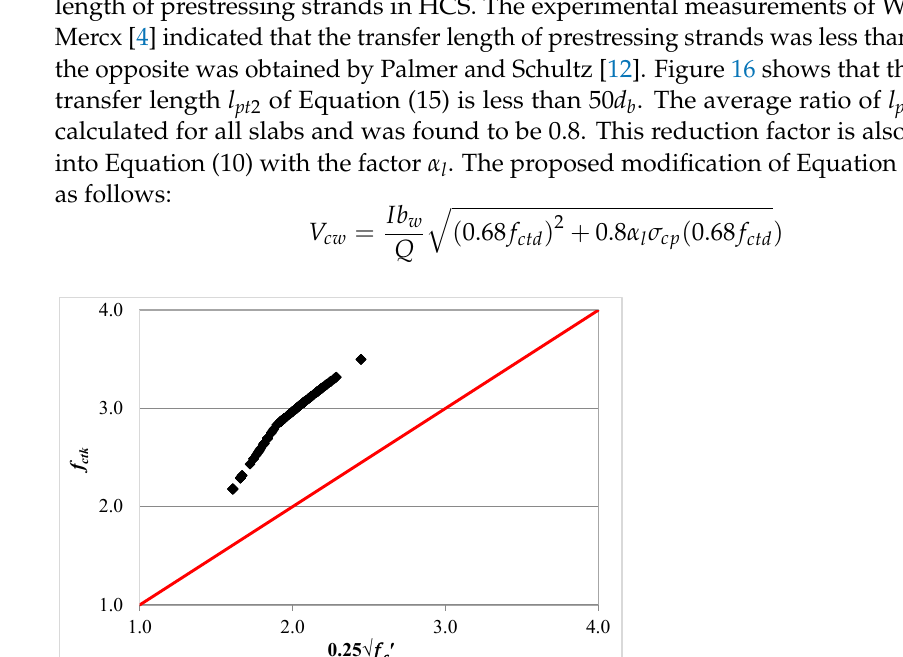
Figure 15. Calculated tensile strength of the concrete f ctk versus 0.25(cid:3493)𝑓 (cid:3030)(cid:4593)